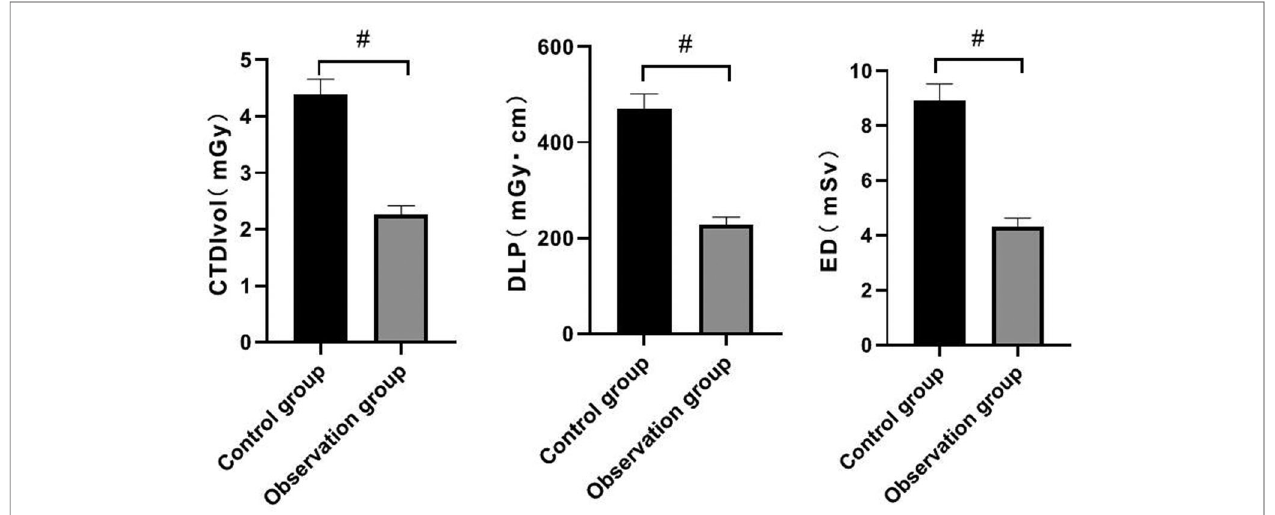
FIGURE 1 | Comparison of radiation doses between the two groups. Note: Compared with the control group, # P